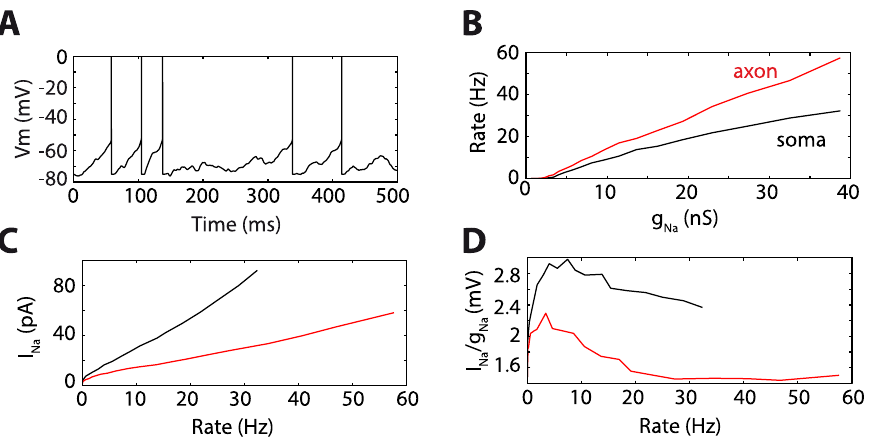
Figure 5. Energy consumption with spike initiation at the soma and in the axon. A, Response of the neuron model with Na channels at 40 m m away from the soma to a fluctuating current injected at the soma. Since there are only Na channels in the model, the membrane potential is reset when half of Na channels are open (spikes are added to the trace for readability). B, Firing rate as a function of maximum Na conductance, when channels are in the axon (red, 40 m m from the soma) and at the soma (black). C, Average Na current as a function of output firing rate, for both cases. D, Same as C, but normalized by the maximum Na conductance (essentially reflecting the average proportion of open channels).